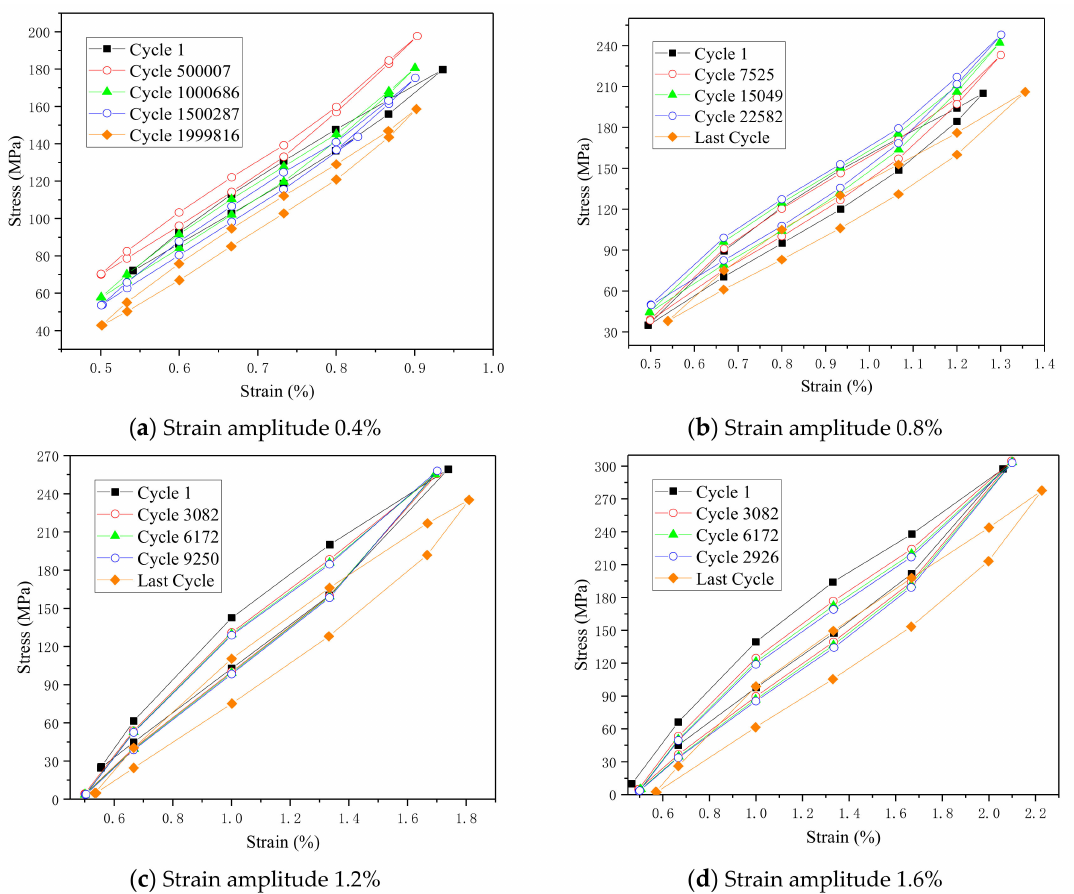
Figure 5. Hysteretic curves of di ff erent strain amplitudes: ( a ) 0.4%, ( b ) 0.8%, ( c ) 1.2%, and ( d )